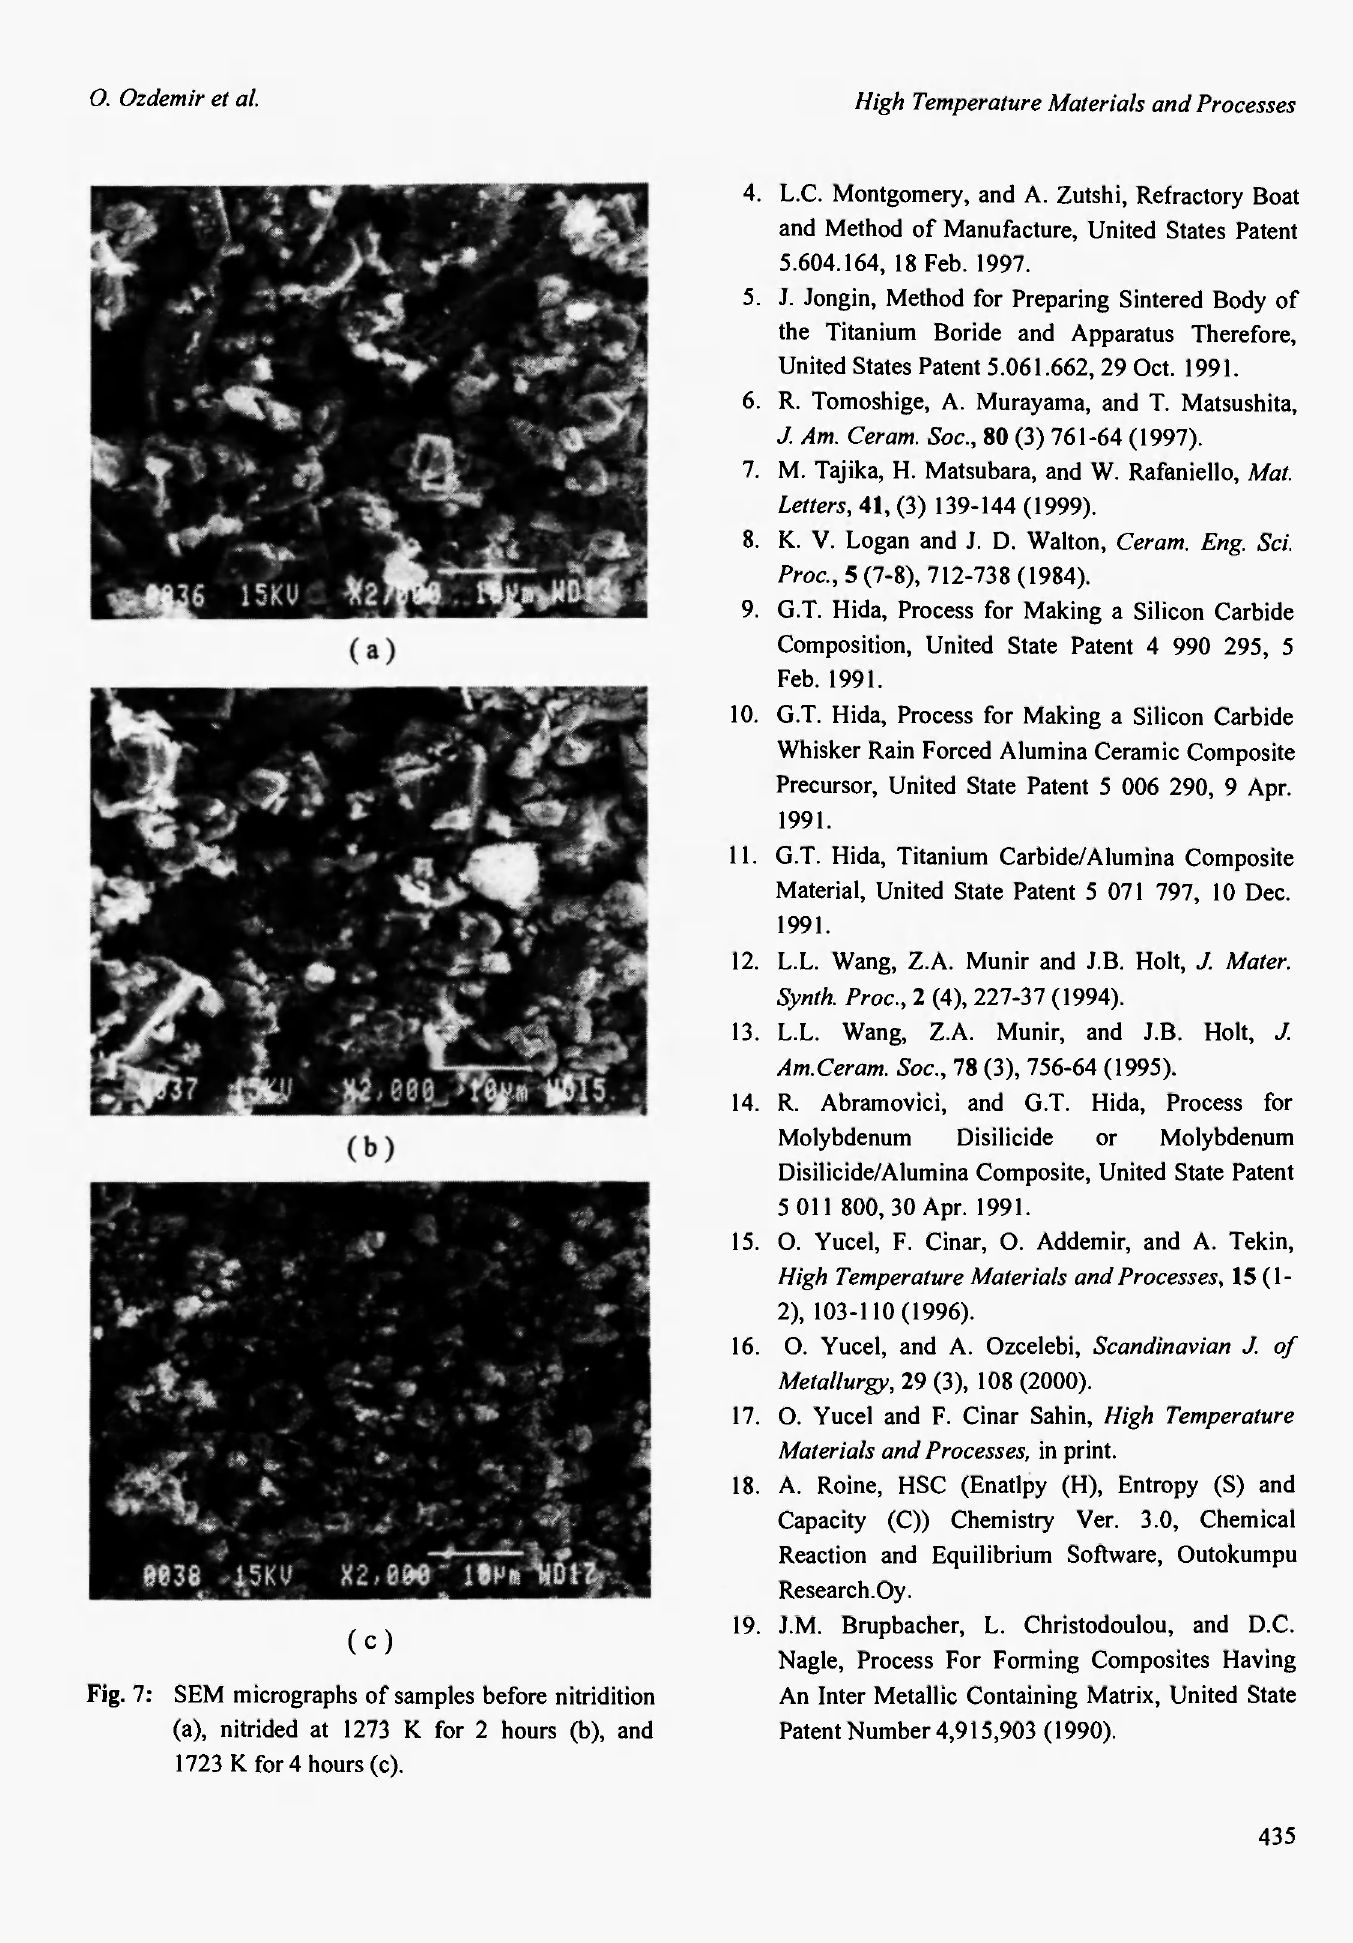
Fig. 7: SEM micrographs of samples before nitridition (a), nitrided at 1273 Κ for 2 hours (b), and 1723 Κ for 4 hours